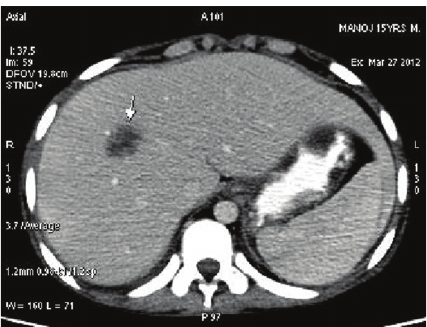
Figure 1: Hepatic and splenic granuloma.